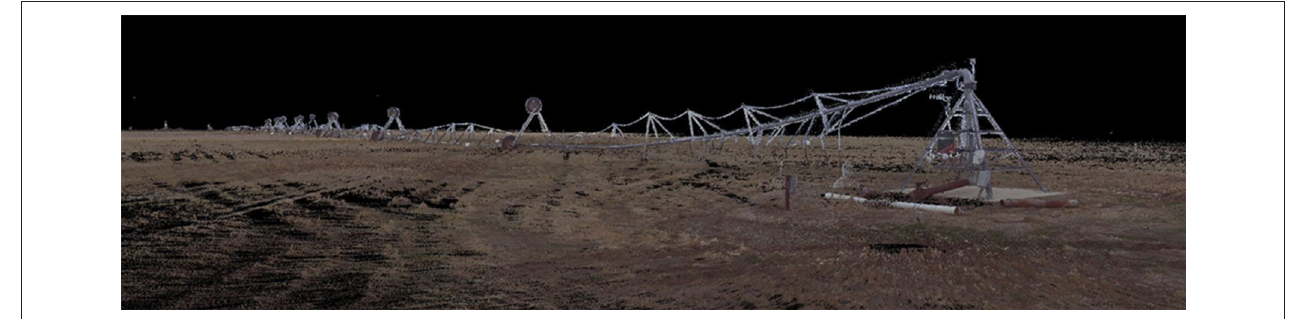
FIGURE 14 | Lidar point-cloud data for overturned center-pivot irrigation system at Pampa, TX. (Image Credit: R. L. Wood/M. E. Ebrahim Mohammadi).